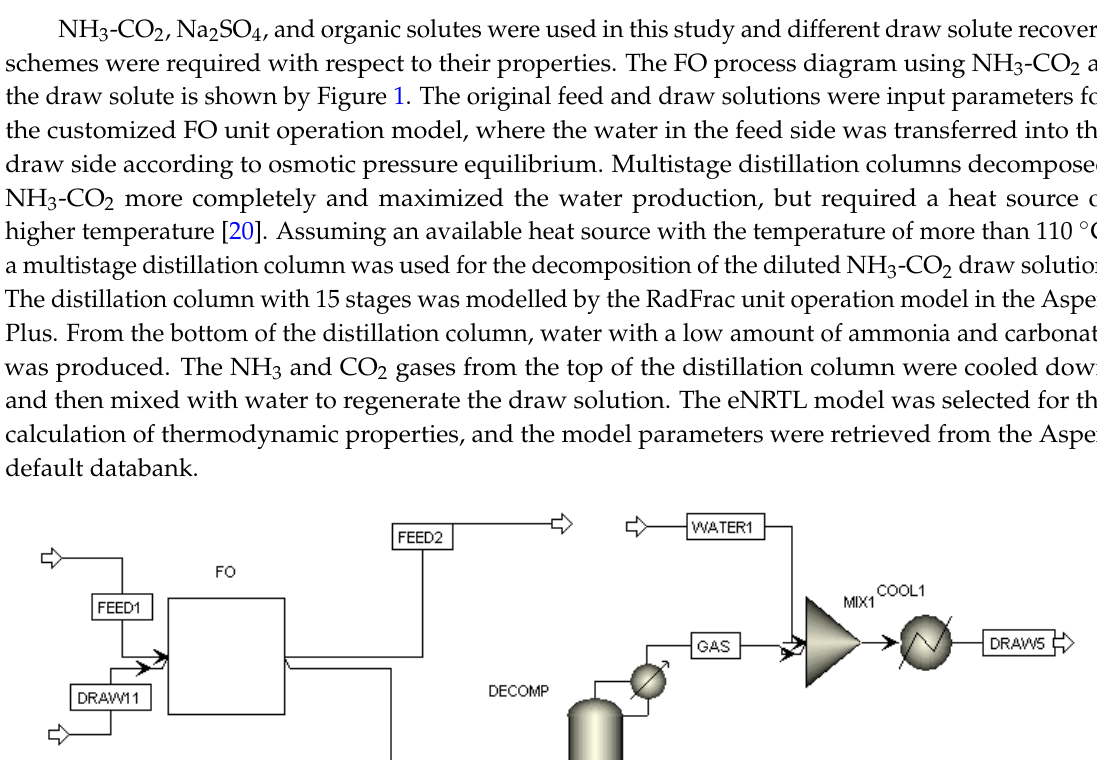
3 -CO 2 as the draw